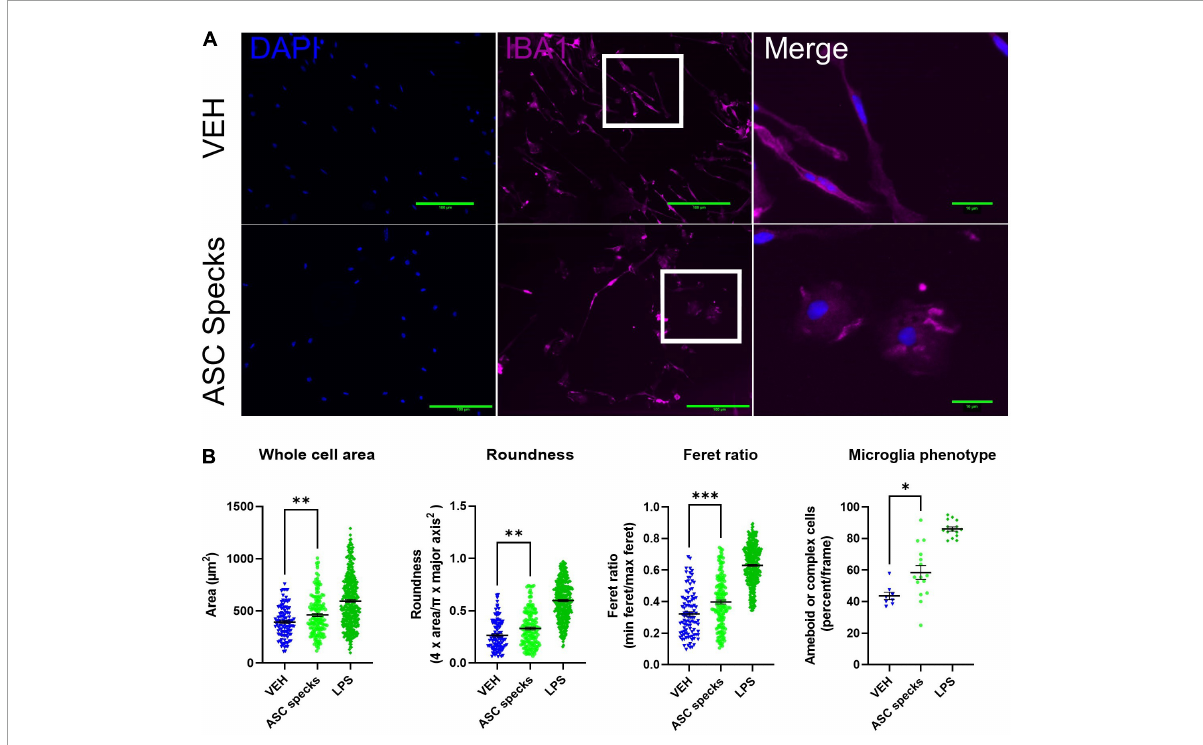
FIGURE1 Aggregated ASC specks alter microglia shape. Iba1 immunocytochemistry was conducted to quantify cell morphology. (A) Microglia were stimulated with ASC specks (43.6 µ g/mL) or vehicle (VEH) for 12 h. Microglia structure was visualized with Iba1 (magenta) while the nucleus was stained with DAPI (blue). Microglia that are enlarged are indicated by the white box and shown in the far-right column of each row. (B) Consistent with a modification in shape, ASC speck treatment resulted in a morphological shift in microglia. The experiment was conducted one time with three technical replicates (wells) and the values reported are the measurement from each individual cell; VEH n = 103 cells, ASC speck n = 147 cells, and LPS = 360 cells. The percentage of proinflammatory microglia per frame is also altered by treatment; VEH n = 8 images, ASC speck n = 15 images, and LPS = 15 images). Values are reported as mean ± SEM; Unpaired Student’s t -test compared to VEH; ∗ P ≤ 0.05, ∗∗ P ≤ 0.01, and ∗∗∗ P ≤